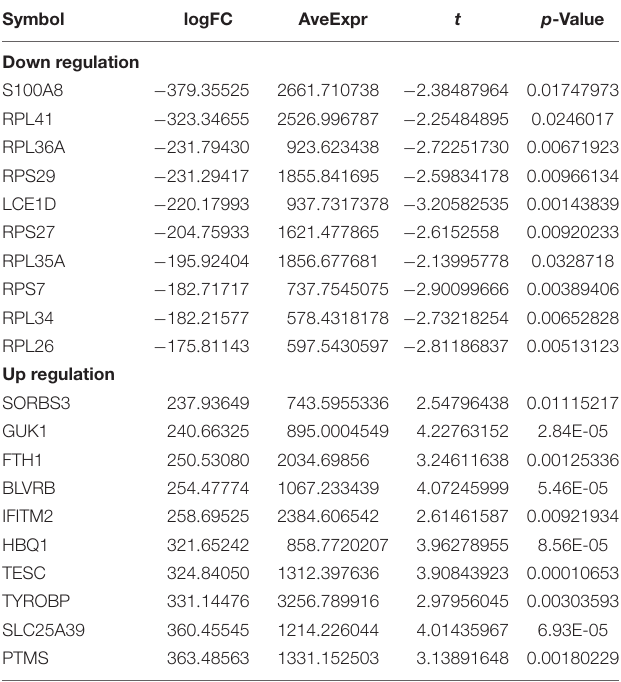
TABLE 2 | Top10 (up- and down-regulated) of differentially expressed mRNAs in Alzheimer’s disease expression profile.